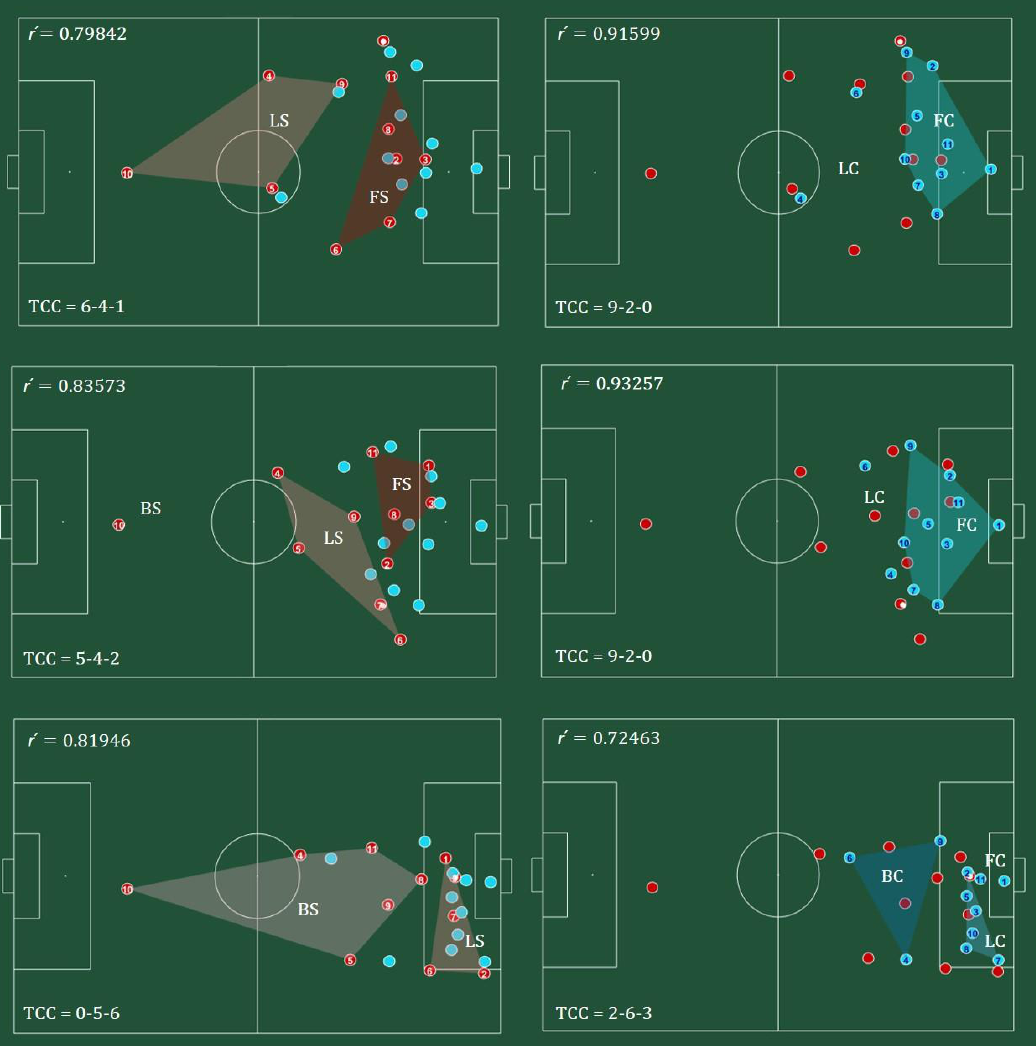
Figure 6. Convex hull of each subgroup in each configuration, in three selected frames of the match. Left: configurations of the team with ball (red). Right: configurations of the team without ball (blue). Subgroups are represented by the codes: FS/C — Front Support/Cover; LS/C—Lateral Support/Cover; BS/C—Back Support/Cover. On the top-left corner of each frame there is the synchronization ( 𝑟́ ) value and on the bottom-left corner, the team configuration code (TCC). The ball is represented by a white filled